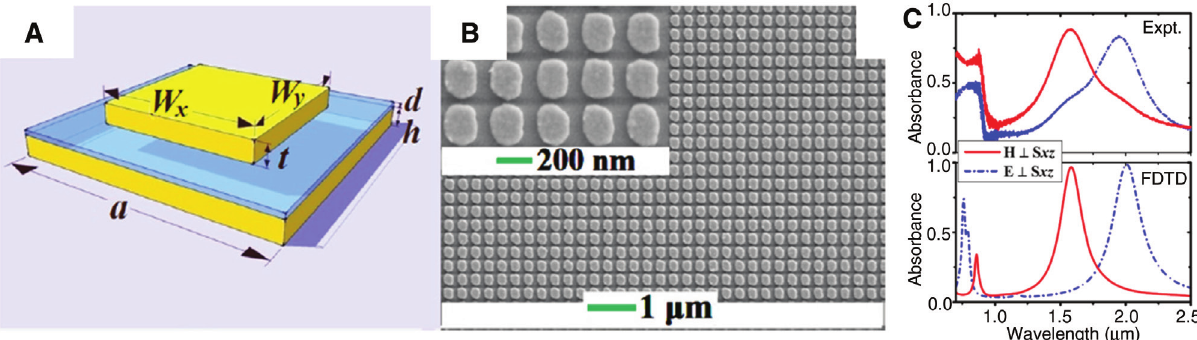
and W represent, respectively, the side lengths of rectangular Au par- Figure 18: (A) Geometry of the sample studied by Hao et al. [44], W x y ticles along the x and y axis and t represents its thickness. d and h, respectively, denote the thicknesses of the Al O dielectric spacer and 2 3 the gold film. a is the lattice constant. (B) Top view SEM image of the fabricated optical metamaterial absorber. (C) Measured and simulated = 170 nm, W = 230 nm, t = 40 nm, d = 10 nm, h = 50 nm, and a = 310 nm at 20 ° angle of incidence. absorbance spectra for a sample with W x y For TM polarized light, the maximum absorption of 88% is obtained at the wavelength 1.58 μ m while for the case of TE polarized light, the maximum absorption can be as high as 83% and the resonance wavelength is shifted to 1.95 μ m. Reprinted with permission from Appl.